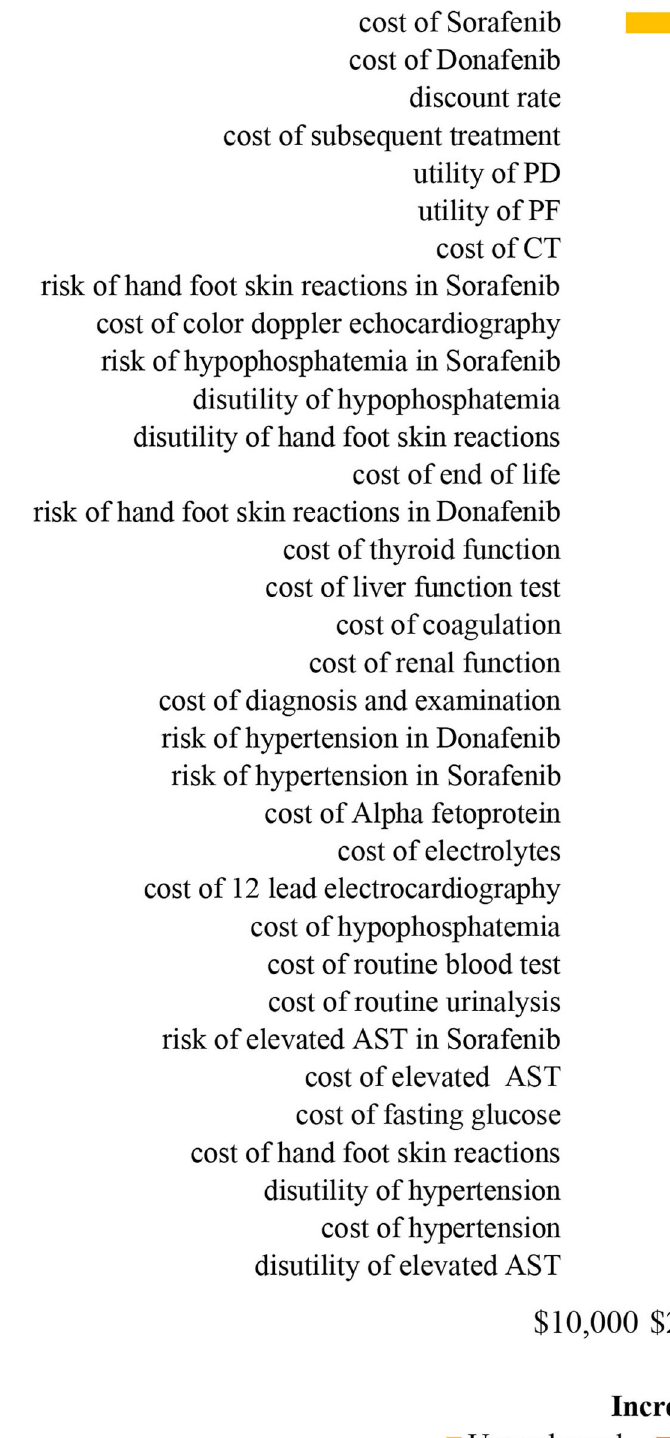
Frontiers in Public Health |